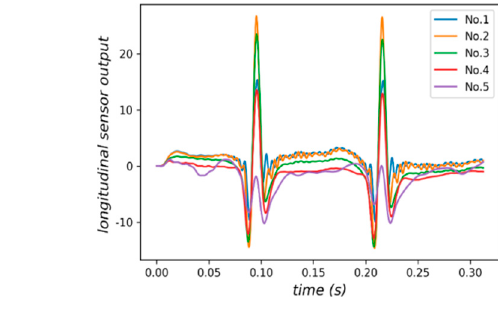
Figure 13. Outputs of sensors placed in different depth with NO. 1 vehicle load model.